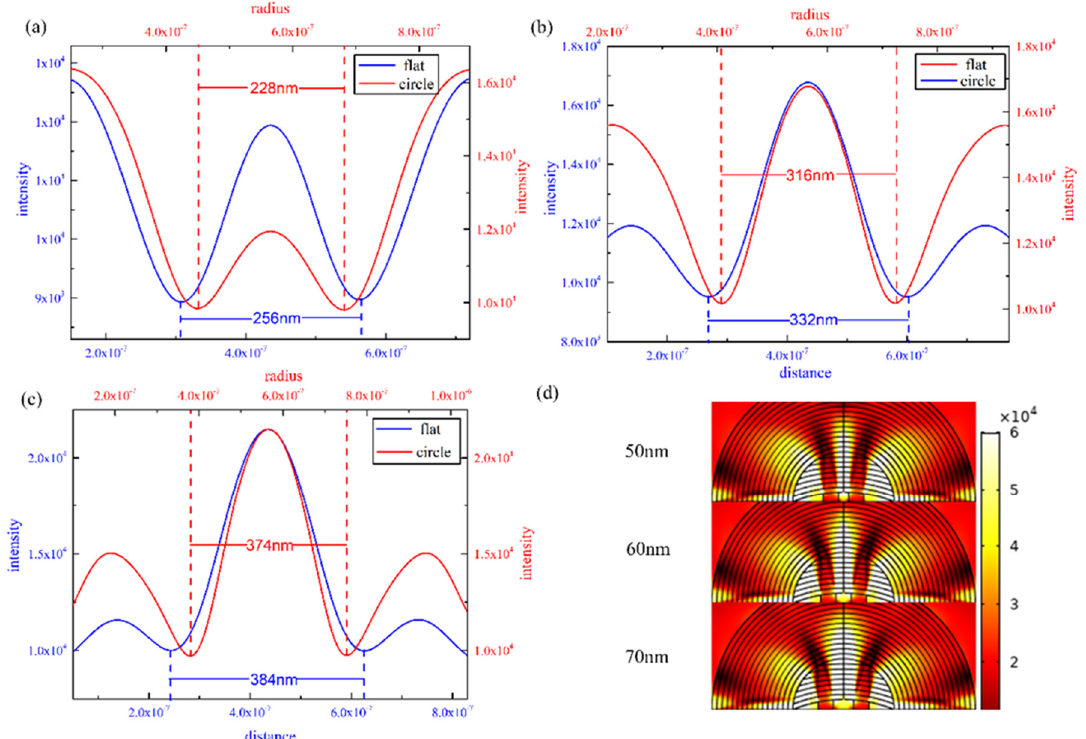
Figure 6. ( a ), ( b ), and ( c ) Electric field intensity distribution along line with 100 nm distance above the hyperlens (blue lines) and semicircular arc with 100 nm distance above the hyperlens (red lines) expressed by line graphs. The center-to-center distance is 50 nm ( a ), 60 nm ( b ), and 70 nm ( c ), respectively. ( d ) Electric field intensity distribution in the hyperlens with di ff erent center-to-center distances between the